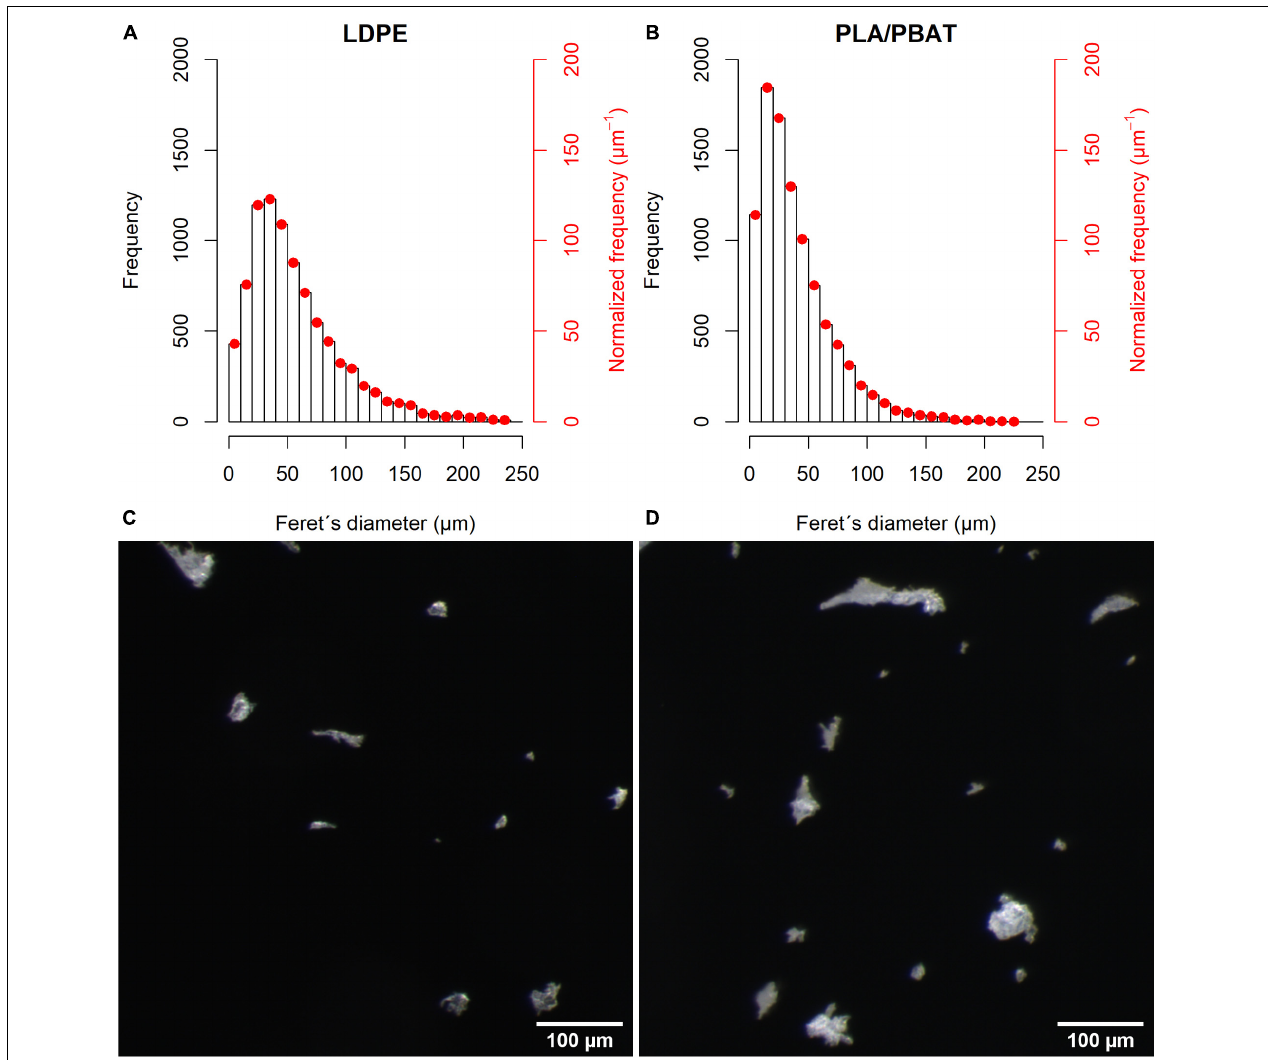
FIGURE 1 | The particle size distribution of (A) LDPE and (B) PLA/PBAT. The second ordinate shows the normalized frequency according to Filella (2015). Micrograph of (C) LDPE and (D)